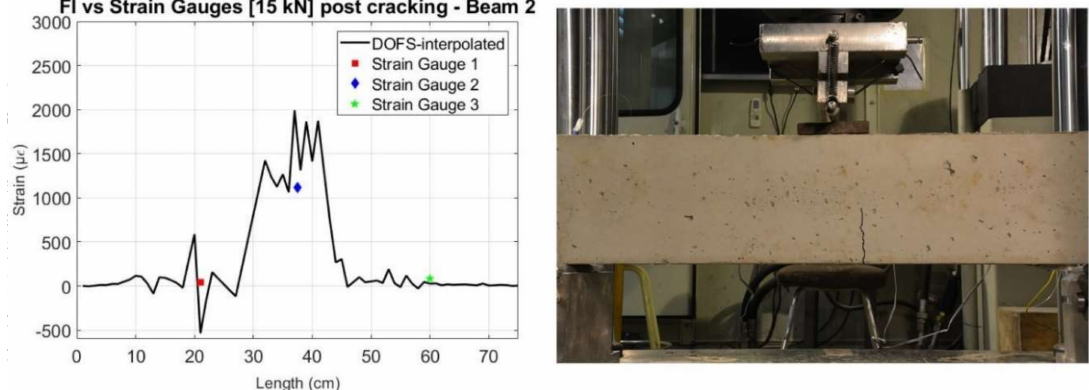
Figure 23. Comparison of interpolated values of DOFS with Strain Gauges for a 15 kN load ( left ) and photo of beam specimen with highlighted crack ( right )—Beam